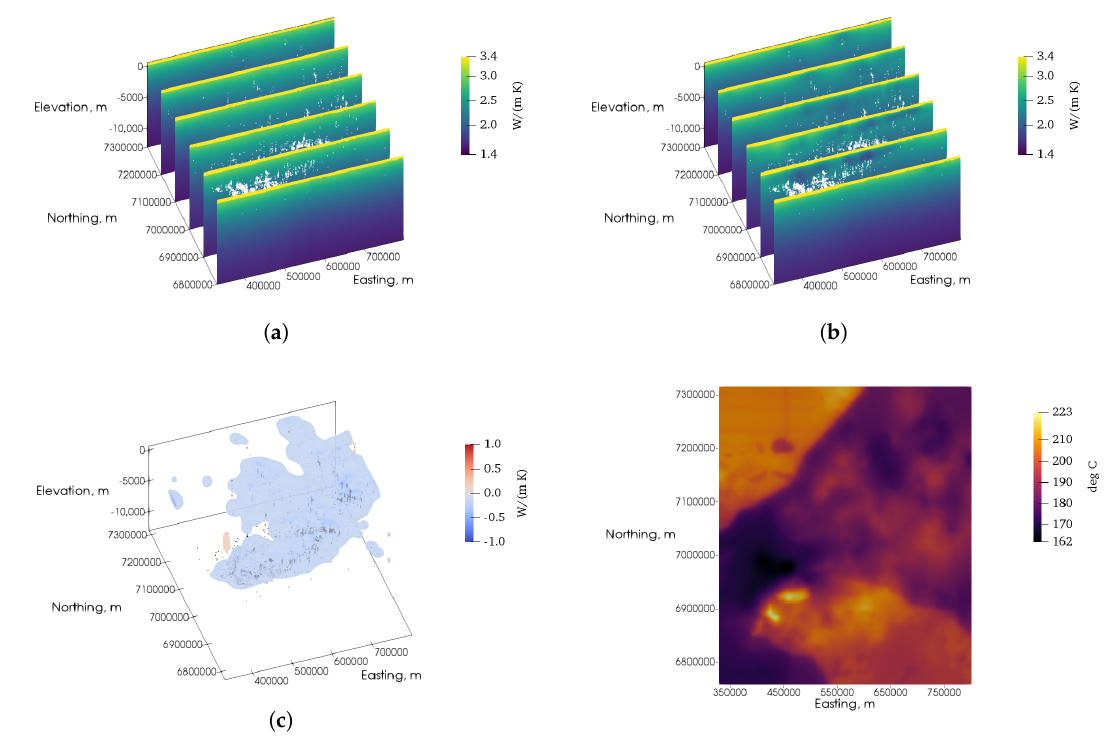
Figure 8. ( a ) Cross-sections of a reference thermal conductivity model built from a homogeneous lithology model, with a vertical exaggeration factor of 20. The model incorporates the temperature dependence of thermal conductivity. Data locations are shown in white. ( b ) Cross-sections of an inversion of OZTemp borehole temperature data using the model in Figure 8a as a reference model, with a vertical exaggeration factor of 20. Data locations are shown in white. ( c ) The inverted thermal conductivity model minus the homogeneous reference model, thresholded to show differences greater than 0.15Wm − 1 K − 1 . Data locations are shown in black. The model is slightly transparent to allow all data locations to be seen. ( d ) Plan view of predicted temperature at 4 km depth, computed using the thermal conductivity model shown in Figure